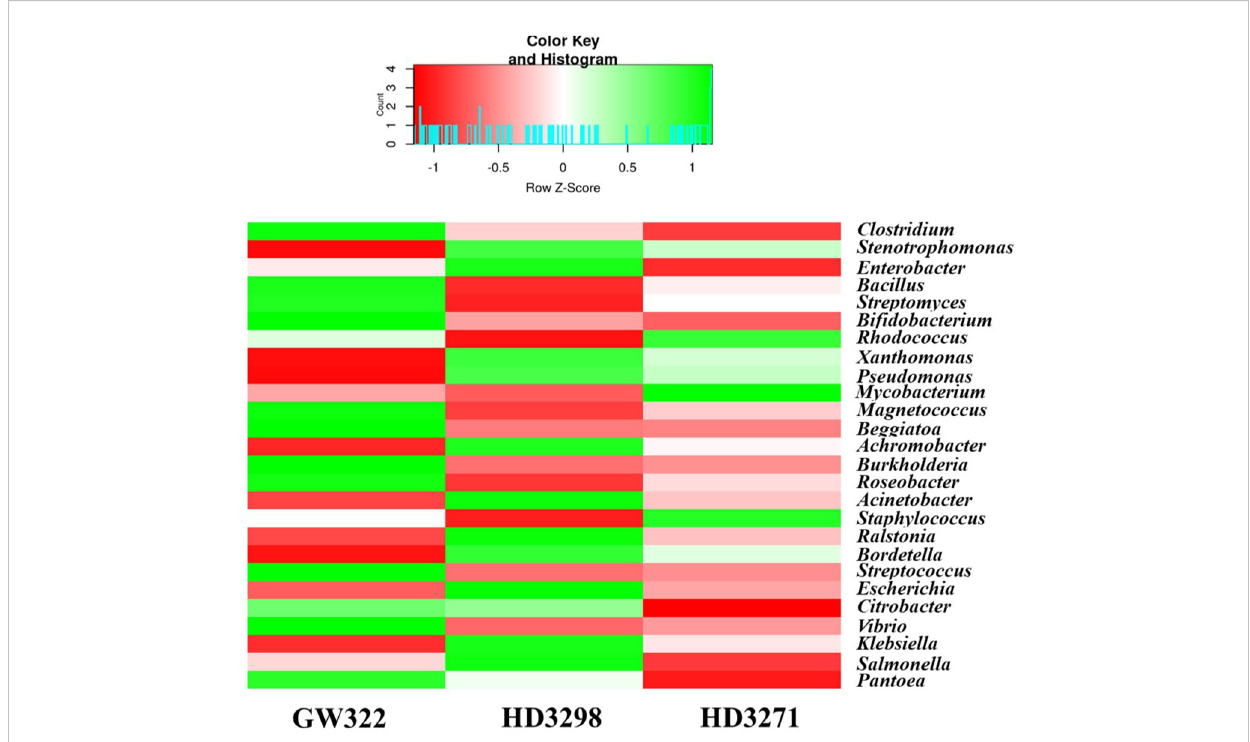
FIGURE 6 Heatmap showing the abundance pro fi le of dominant bacteria (top 25 genera) from the metagenomic